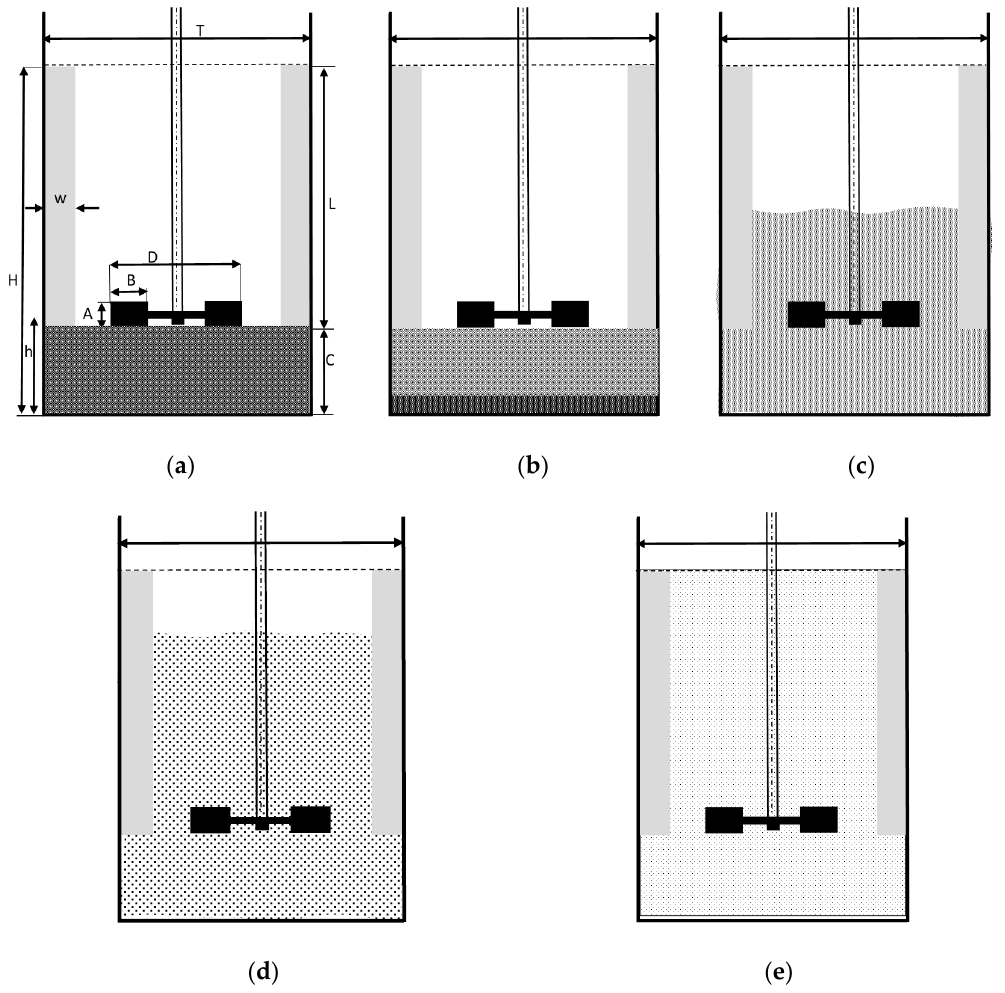
Figure 2. Particle suspension in the solid-liquid rotating vessel in reference to the rotational speed: ( a ) particle deposited at the bottom of the tank; ( b ) particles get lifted by the rotating flow; ( c ) clear liquid and the suspension line; ( d ) suspension the necessary condition; ( e ) homogeneous distribution.